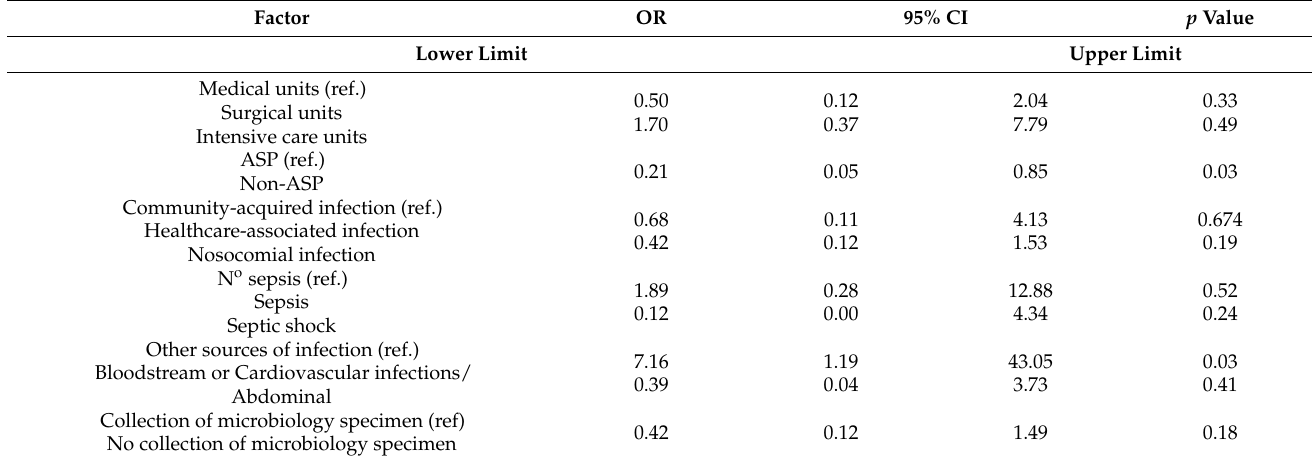
Table 3. Logistic regression analysis for independent factors related to prescriptive appropriateness.